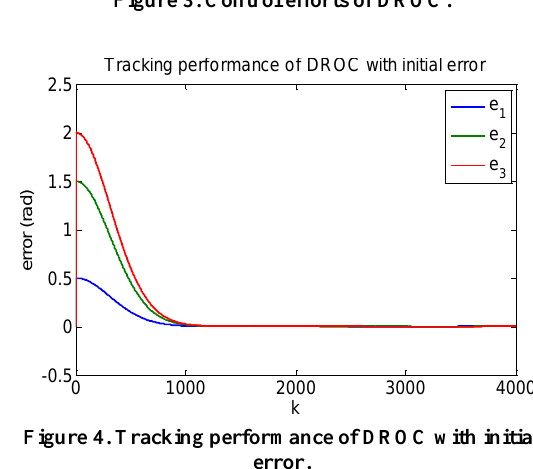
Figure 3. Control efforts of DROC.